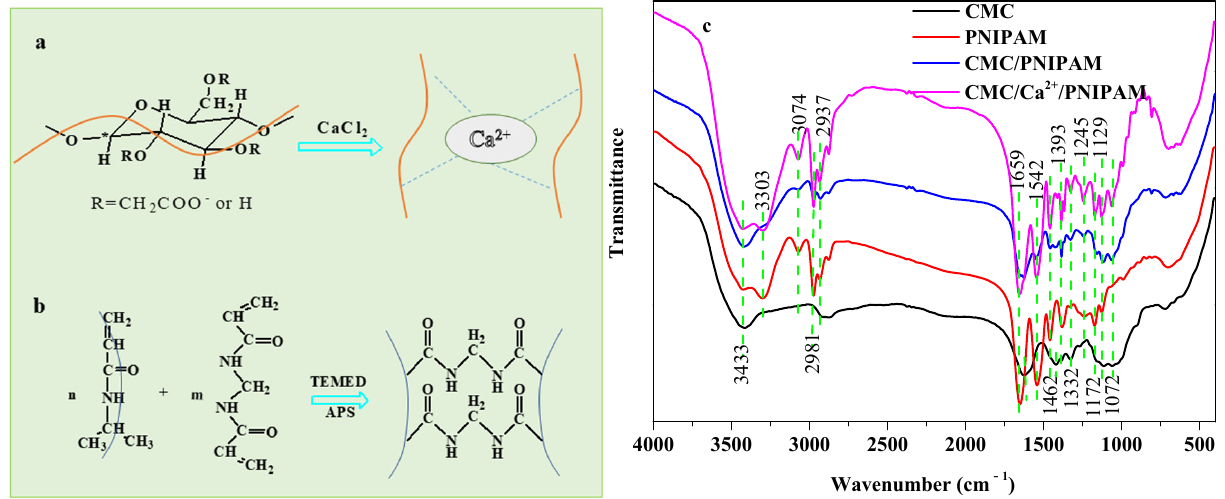
Figure 1. ( a , b ) Synthesis of CMC/Ca 2+ /PNIPAM aerogels. ( c ) FTIR spectra of CMC and PNIPAM, CMC/PNIPAM, and CMC/Ca 2+ /PNIPAM aerogels. CMC/PNIPAM, and CMC/Ca 2+ /PNIPAM